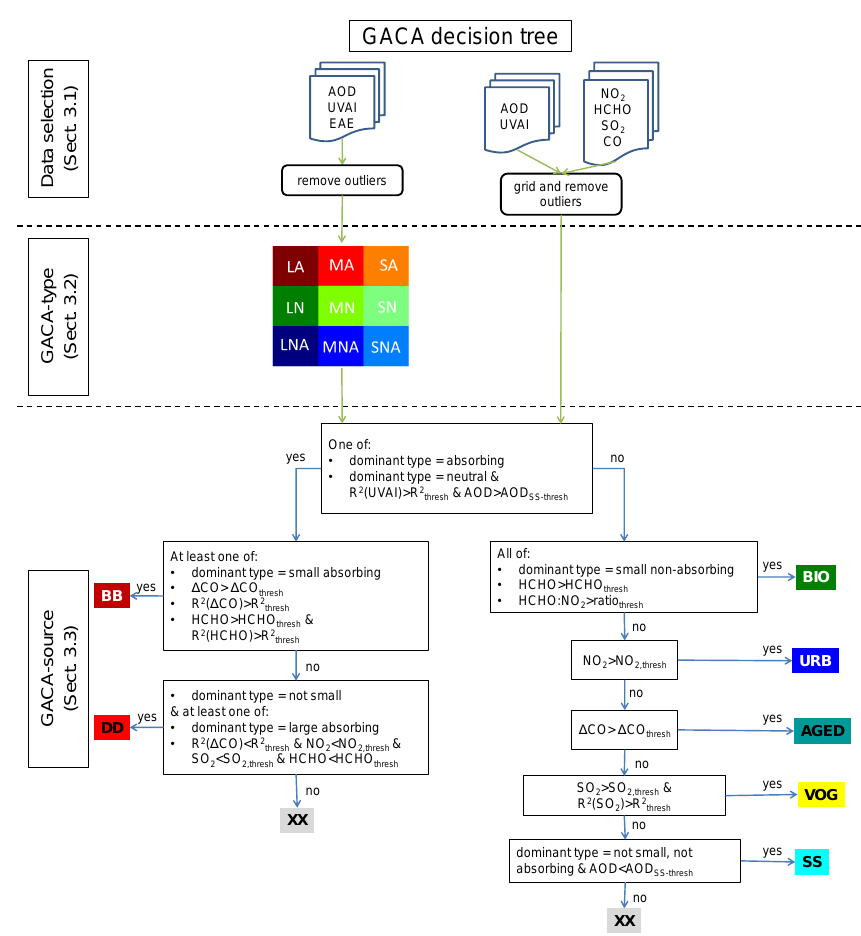
Figure 2. Schematic decision tree of GACA. The corresponding threshold values are given in Table 3. The mean value of a quantity, e.g., (cid:49) CO, is denoted (cid:49) CO; the coefficient of correlation between AOD and a quantity, e.g., HCHO, is denoted R 2 (HCHO). Thresholds are denoted as e.g., SO 2 , thresh , R 2 , ratio thresh (for the HCHO:NO 2 ratio threshold), or AOD SS-thresh (for the maximum AOD allowed for thresh SS classification). Other abbreviations are explained in Table